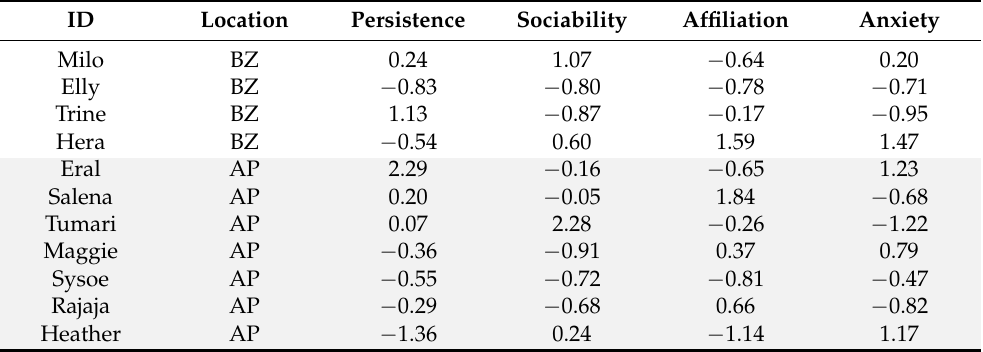
Table 3. Personality scores of all individuals for the persistence, sociability, affiliation, and anxiety components.